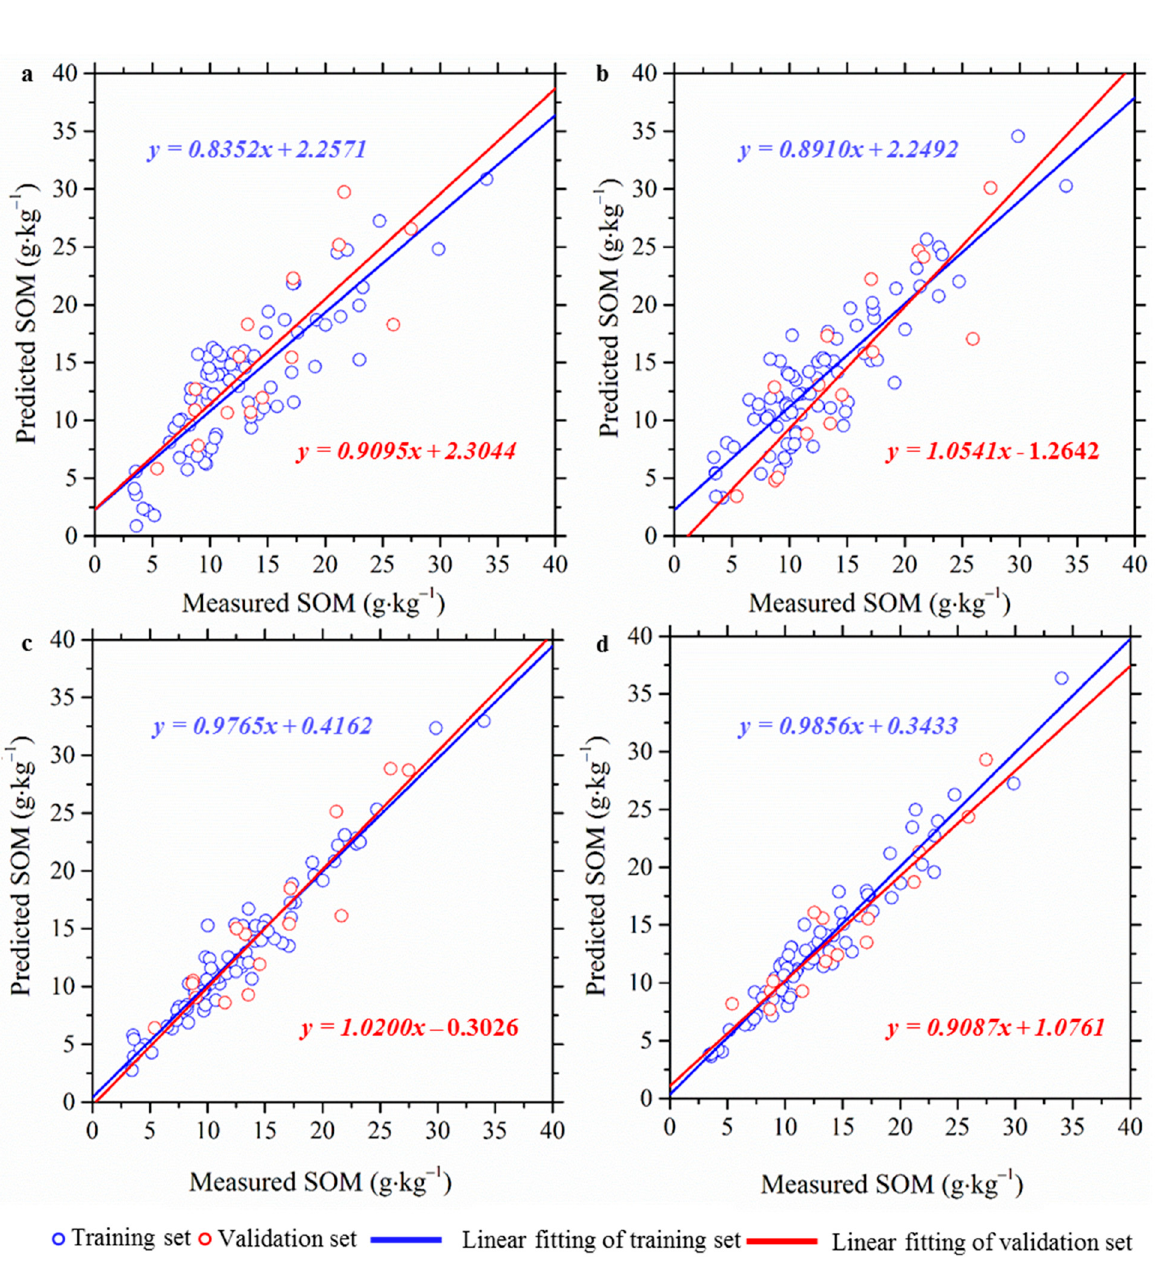
Figure 8. Scatter plots of measured and predicted SOM using averaged covariates at various temporal scales, coupled with ( a ) RR, ( b ) LS-SVM, ( c ) RF, and ( d ) GBRT. Table 3. Evaluation results of SOM estimation based on conventionally averaged covariates in terms of RMSE, R 2 , and RPD, after 20 iterations with the same training and validation sets as the XWT features. Average and standard deviations are shown within parenthesis.